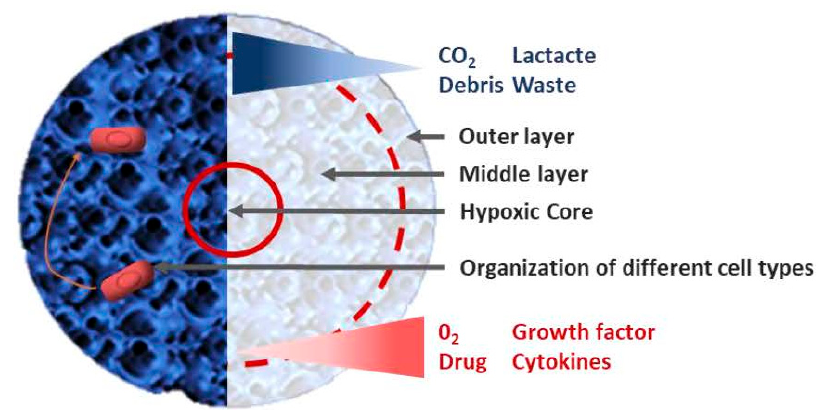
Figure 4. Spheroid organization Tumor spheroids are organized in three different layers with a dying core, a quiescent intermediate layer and a proliferating rim. Stromal cells (in red) are organized in a different way inside the spheroid depending of the context.